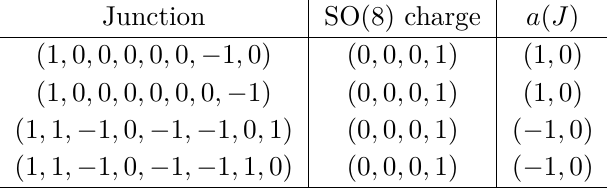
Table 4 . The four junctions with highest weight of 8 v under SO(8)